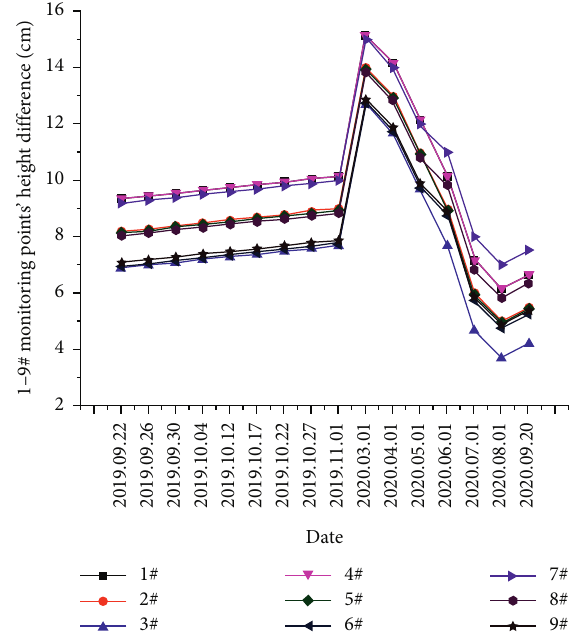
Figure 14: The height difference change diagram of the monitoring point on the